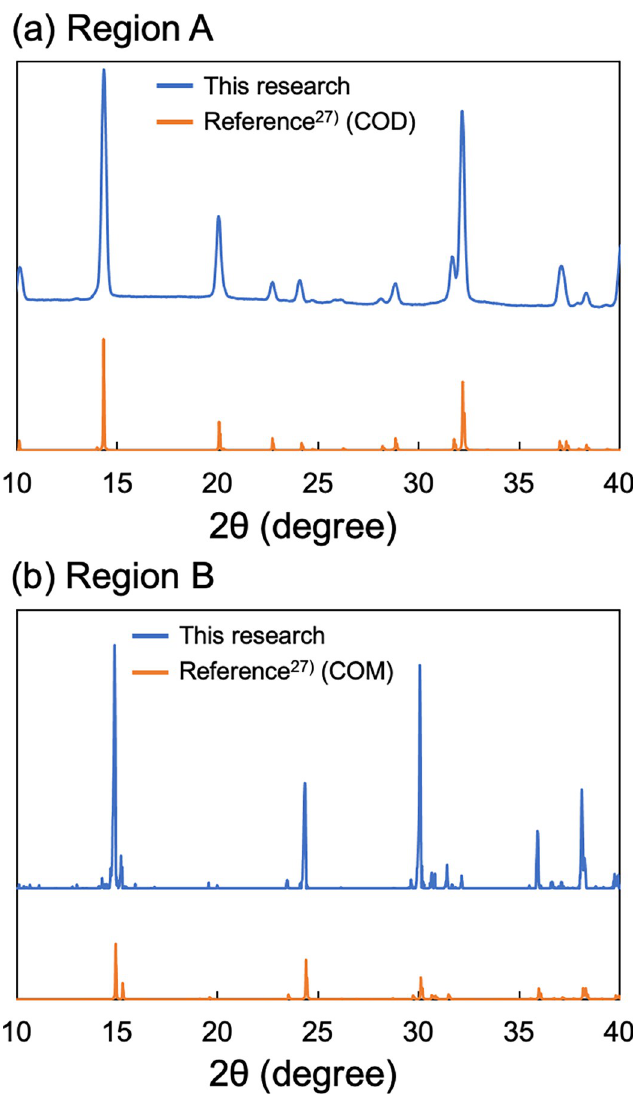
Fig 3. The measurement result of kidney stone sample #1004 by PXRD. (a) The region A results. (b) The region B (shown in Fig 2) results. Upper graphs : The COM or COD result obtained in the present study. Lower graphs : The COM or COD results described in reference